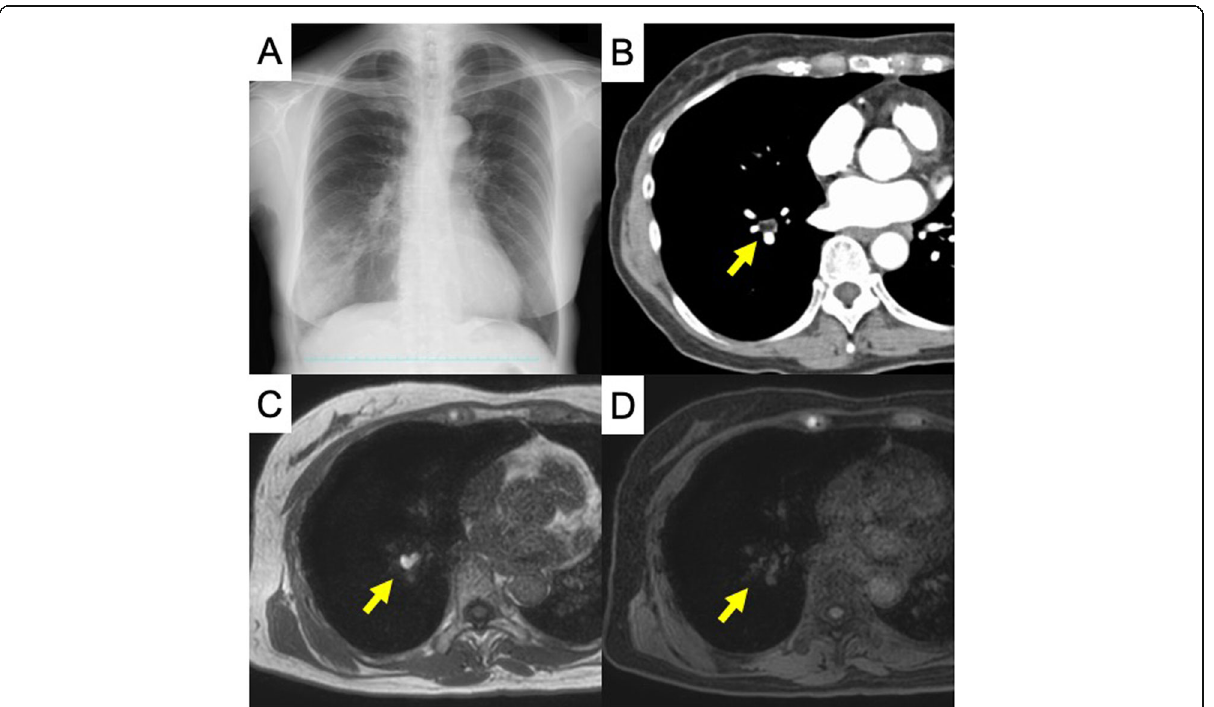
Fig. 1 Preoperative imaging test. a Chest X-ray showing a shadow on the right lower lung field. b Computed tomography image showing a low- density nodule without calcification occluding the lumen of the lateral segmental bronchus of the right lower lobe (B 9 ). c Magnetic resonance image showing a nodule of high intensity on T1-weighted images and d low intensity on fat suppression